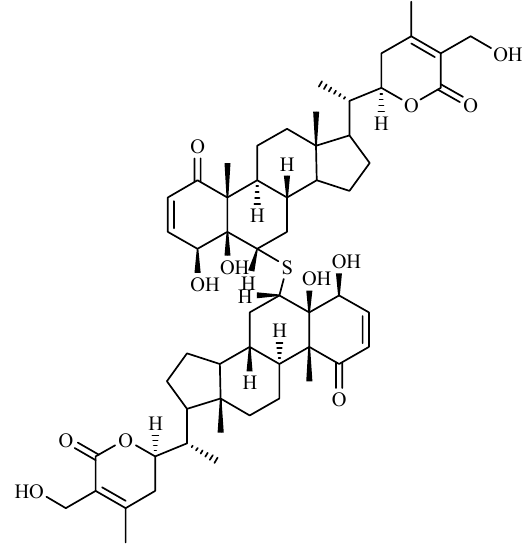
Figure 5. Ashwagandhanolide, a new compound isolated from W. somnifera.